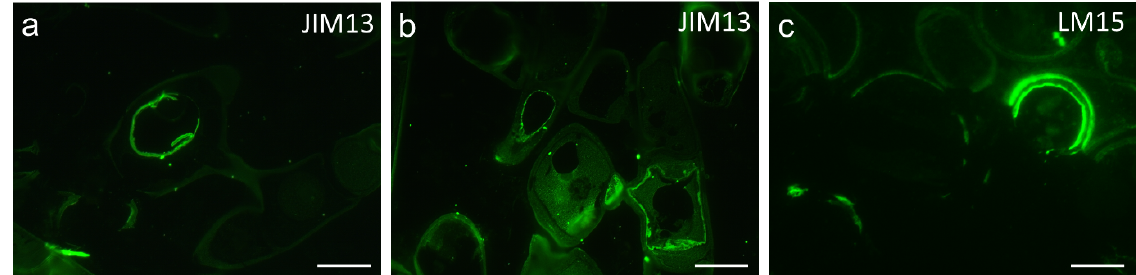
Figure 6. Immuno-localization of certain cell wall components in Spirogyra mirabilis . ( a , b ) JIM13 (AGP) and ( c ) LM15 (xyloglucan) of semi-thin sections of Spirogyra mirabilis , ( a ) zygospore in gametangium, ( b ) conjugating cells, ( c ) bilayer arrangement in zygospores wall. Scale bars 20 µm.